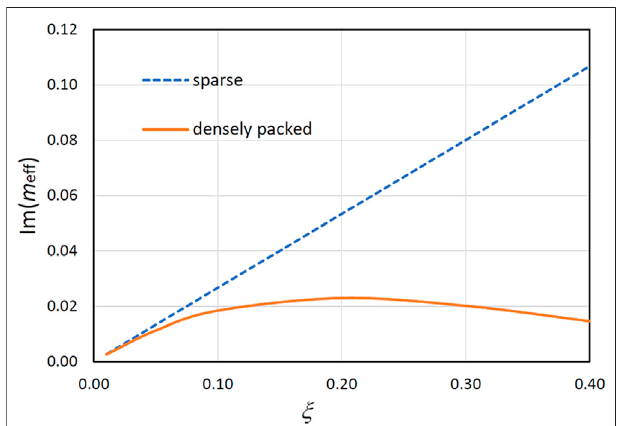
FIGURE 1 | The imaginary part of the effective refractive index of a medium composed of identical spherical particles with x = 1.76 and m = 1.50 + i 0.0001 in dependence on the fi lling factor ofparticles according to Eqs 1 , 2 for sparse (dashed line) and densely packed (solid line) media,